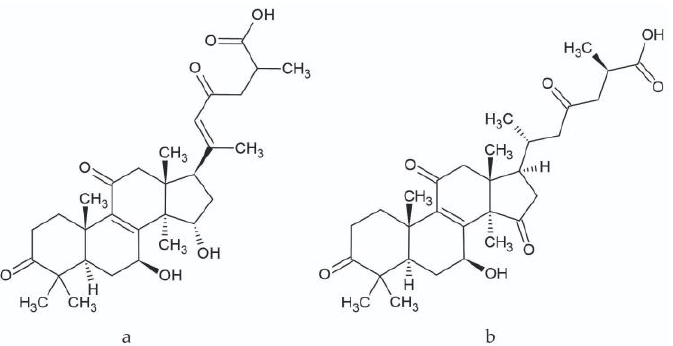
Figure 3. Chemical structure of ganoderic acid A ( a ) and ganoderic acid C ( b )